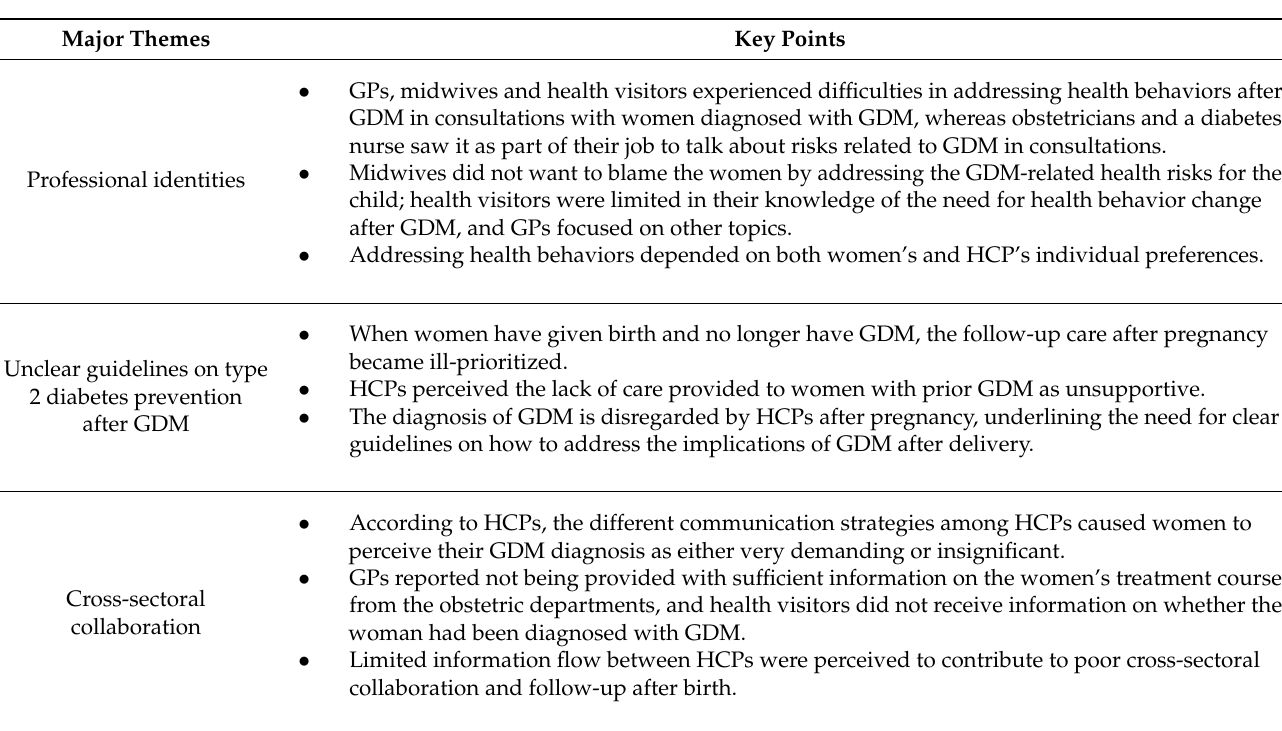
Table 3. Major themes and key points identified in focus groups and